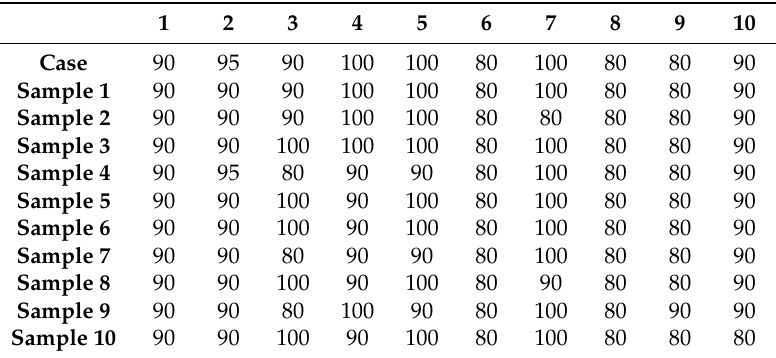
Table 3. The quantitative factor values calculated according to the defined rules.